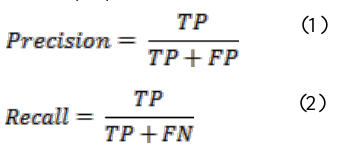
Table 2 . Comparison between participant's methods and the proposed